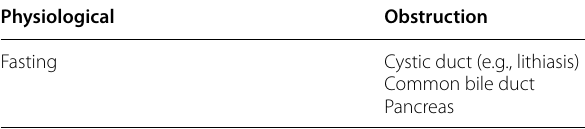
Table 3 Causes of gallbladder distension